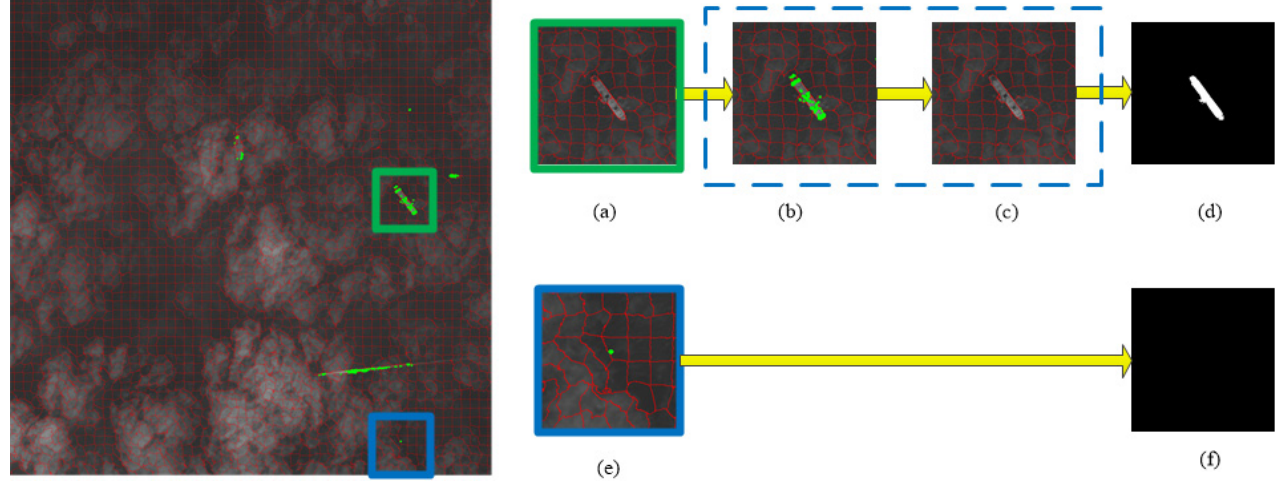
Figure 7. Taking ( e ) in Figure 5 as an example, the process of merging the target superpixel region (green box) and the culling process of non-target feature points (blue box) is shown. ( a – d ) are the results of feature point detection and superpixel merging in the target area. ( e , f ) are the culling results of non-target area feature points.